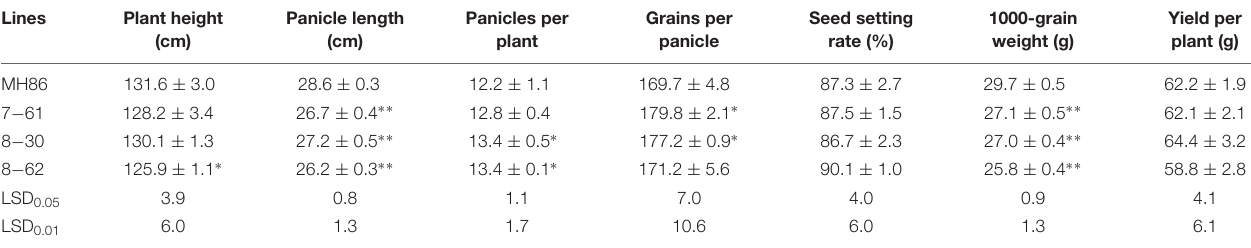
TABLE 3 | Agronomic performance of transgenic homozygous lines in the field. Lines Plant height